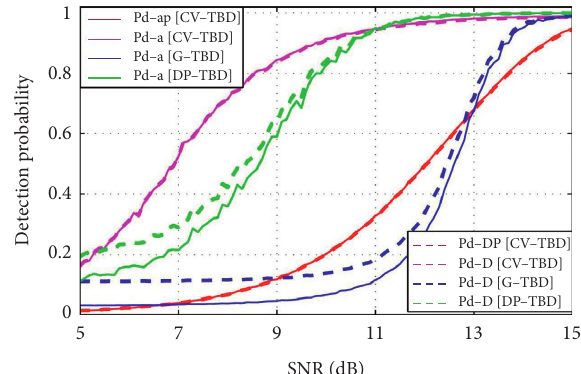
Figure 12: Detection probability versus different SNRs.